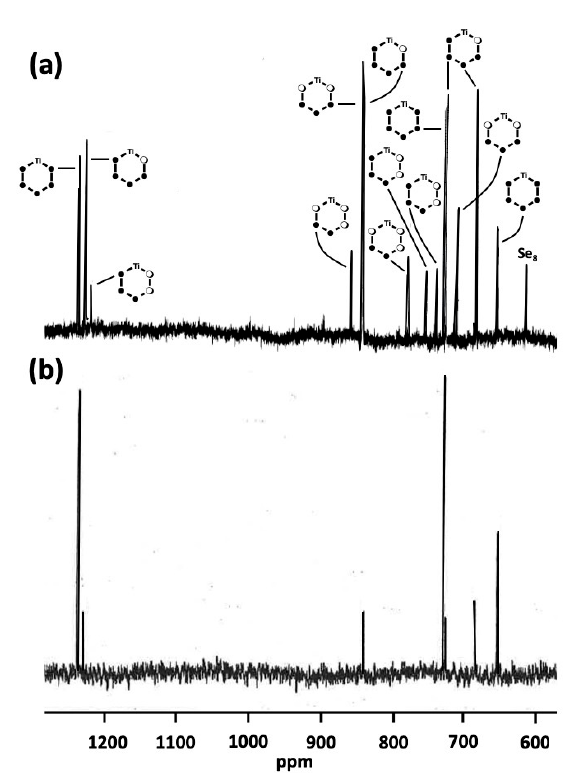
Figure 3. ( a ) The 77 Se-NMR spectrum of phase D recorded previously in CS 2 together with the tentative assignment [15] (adapted with permission from Pekonen, P.; Hiltunen, Y.; Laitinen, R.S.; Valkonen, J. Selenium-77 NMR Spectroscopic and X-ray Crystallographic Characterization of Bis(cyclopentadienyl)titanium Selenide Sulfide Mixtures [Ti(C 5 H 5 ) 2 Se x S 5- x ]. Inorg. Chem. 1991 , 30 , 1874–1878. Copyright 1991 American Chemical Society). ( b ) The 77 Se-NMR spectrum of phase E recorded in CS 2